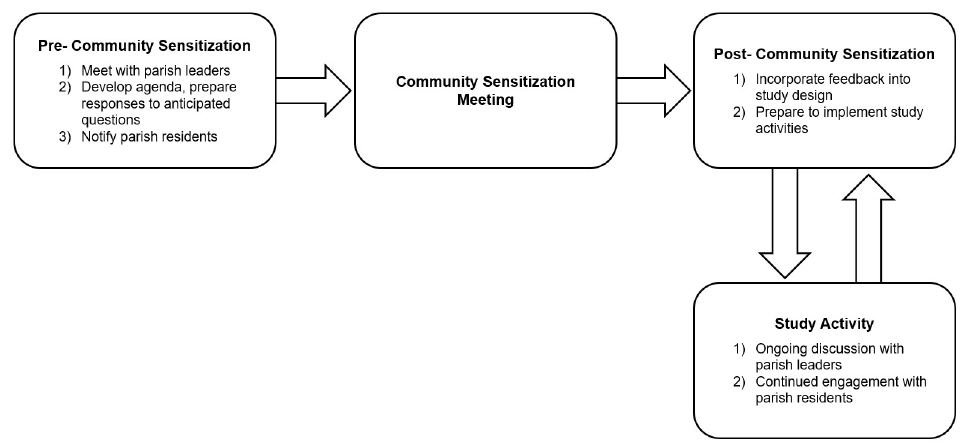
Fig 1. Community sensitization